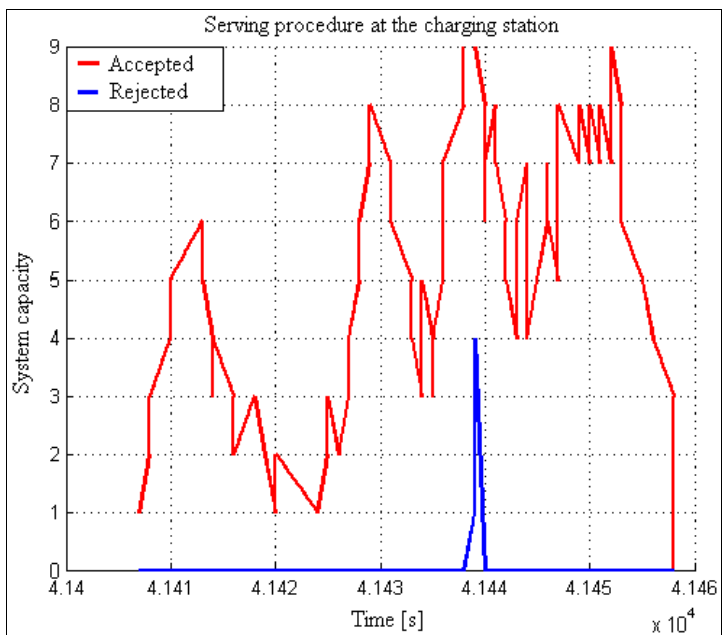
Figure 15. The total number of served users in the observation period, considering the allowed percentage threshold of 11 percent rejection (max. five users in the total quota). U = 47, P = 9.